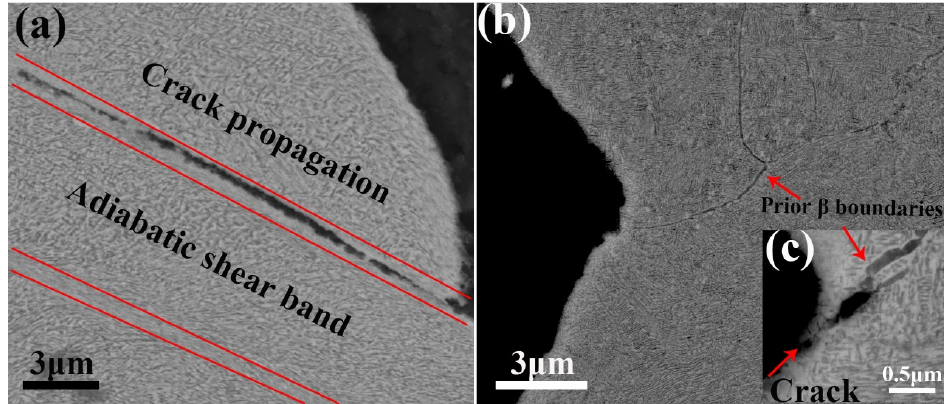
Figure 10. Profile-view SEM micrographs closed to the fracture surface of samples ( a ) 0% CR+ aging and ( b ) 80% CR+ aging. ( c ) An enlarged image showing a micro-crack along the grain boundary.